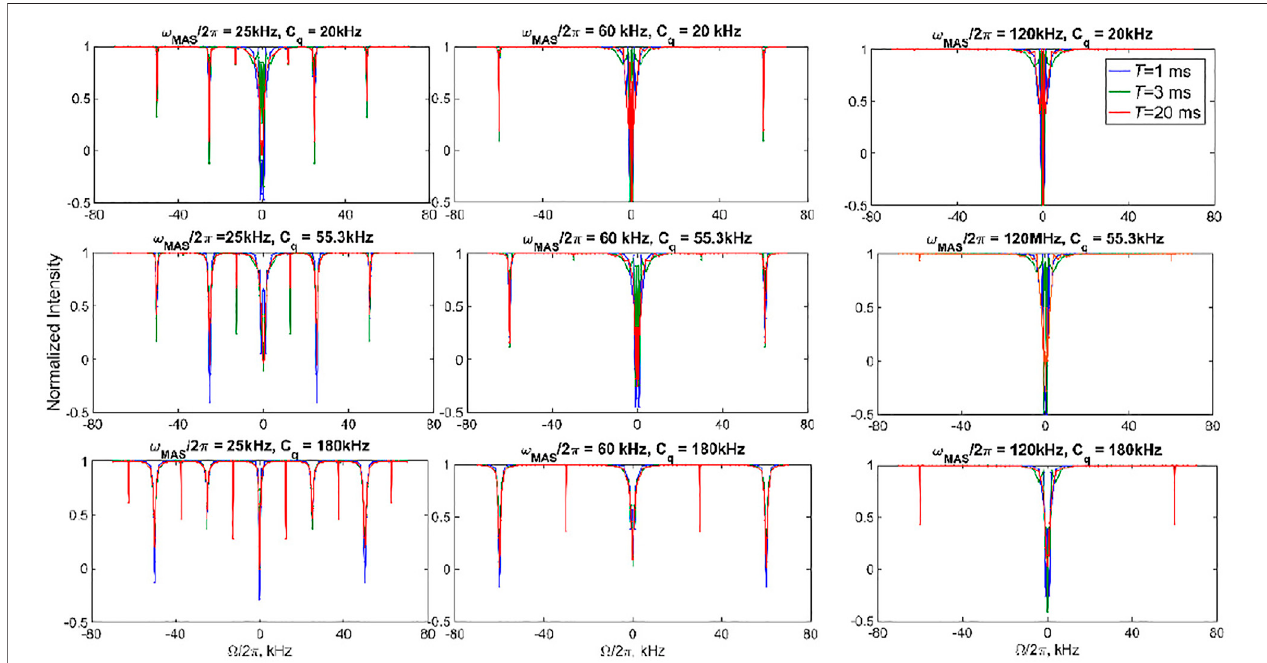
FIGURE 4 | Simulated 2 H CEST pro fi les in the absence of motions. The integrated intensity of all the spectral side bands normalized to intensity at T (cid:2) 0 versus offsets Ω / 2 π for ω RF / 2 π (cid:2) 1.3 kHz and three chosen values of the saturation times T . Values of C q and ω MAS / 2 π are shown directly on the panels. η (cid:2) 0 in all cases.